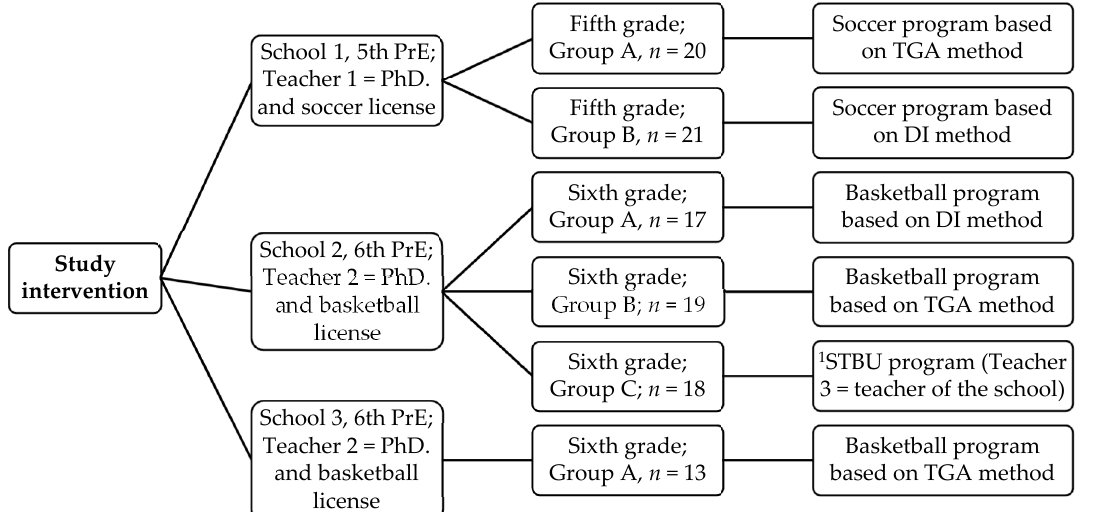
Figure 1. Distribution of student groups by school and educational program. Note: PrE = Primary Education; PhD = Doctorate in Physical Activity and Sport; TGA = Tactical Games Approach methodology; DI = Direct Instruction methodology; STBU = Service Teacher’s Basketball unit; 1 STBU is a teaching unit designed and taught by an in-service teacher.